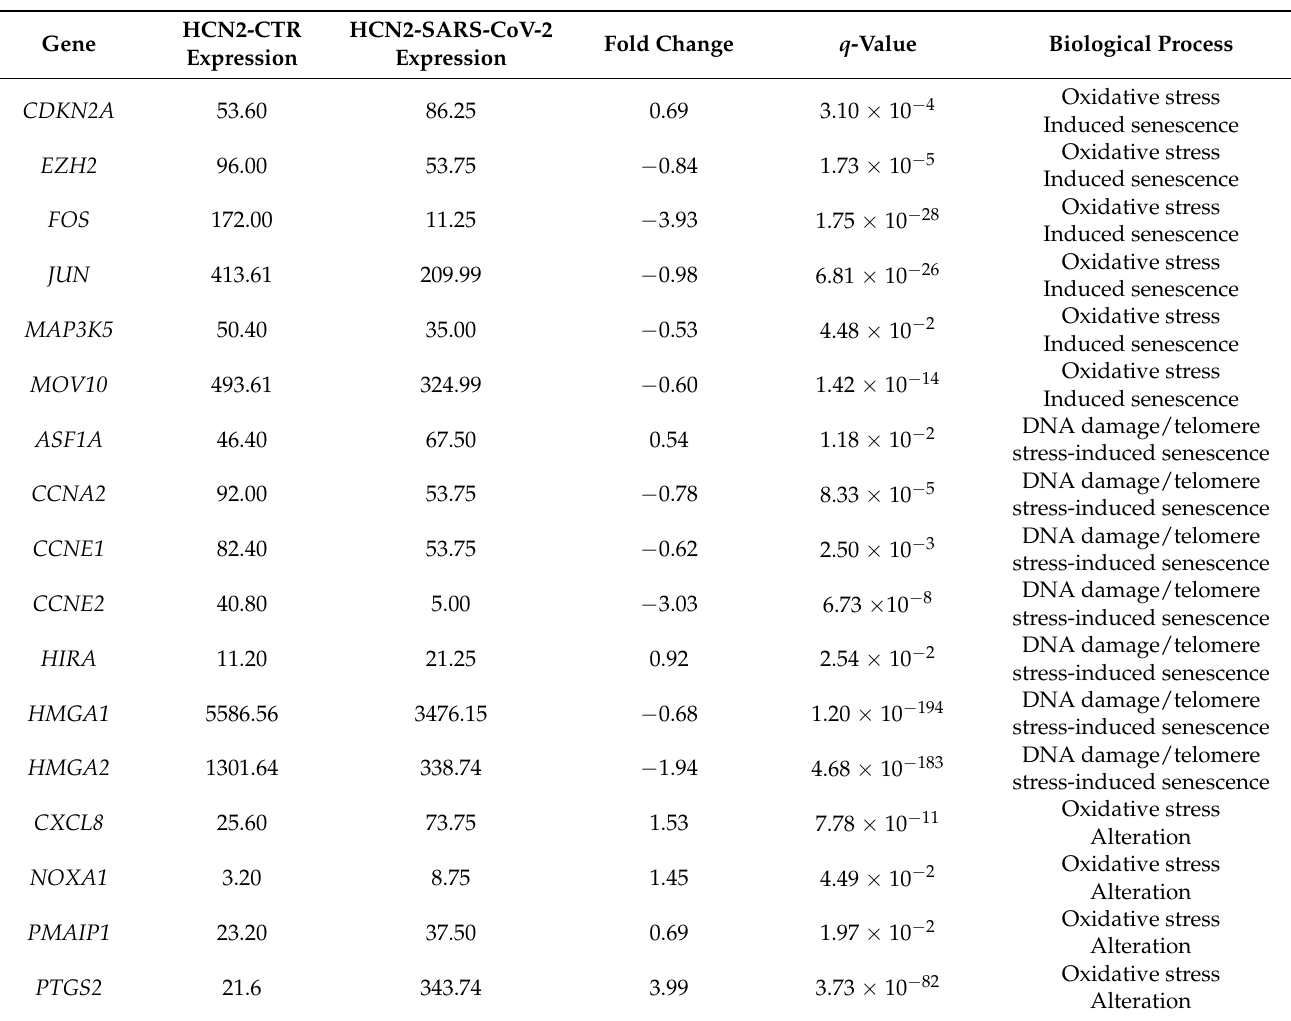
Table 1. Inspected DEGs involved in